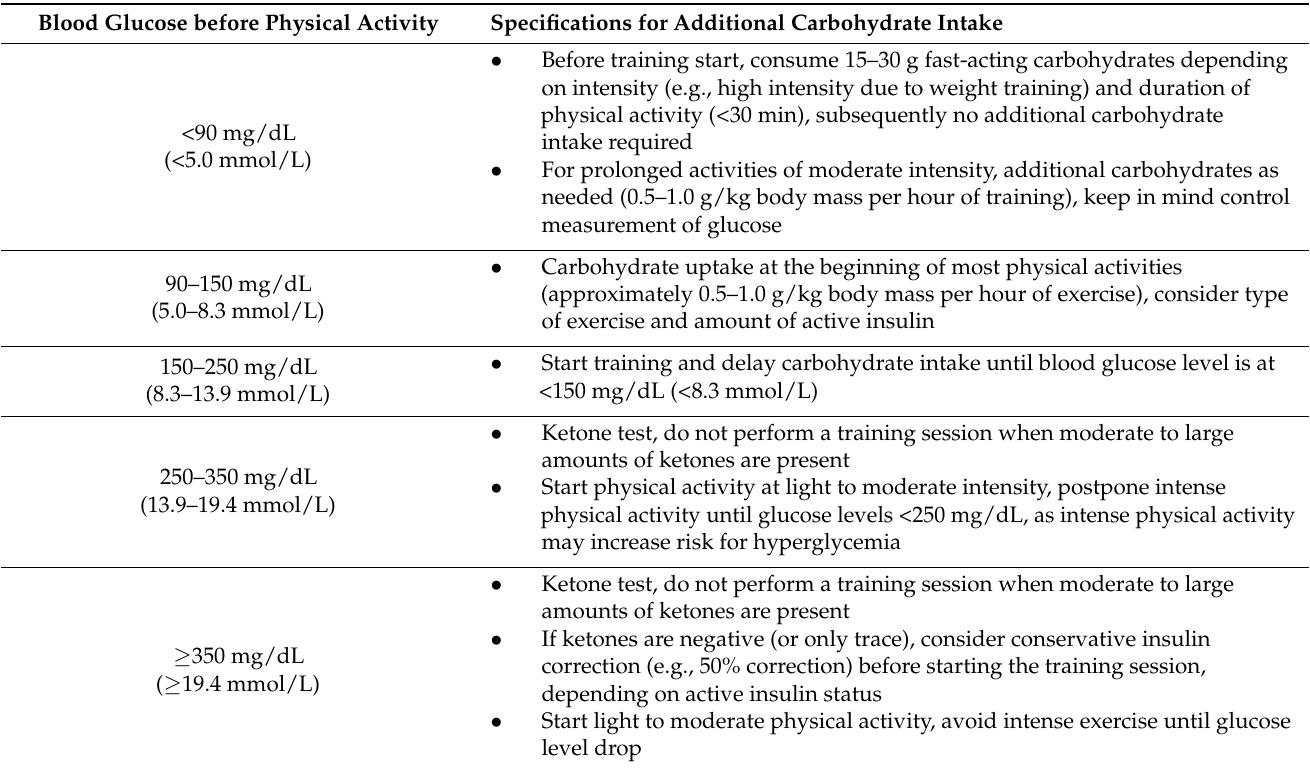
Table 1. Additional carbohydrate intake due to physical activity for insulin-dependent people with diabetes according to ADA recommendations [52].